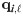
Method adopted to locate points qi,l on surface Q that correspond to points p¯i,l−1 on surface P in the lth iteration.Hashed points p¯i,l−1 (although moving through iterations) and black points q
j are original discrete points of the measurements of surface P and surface Q. Surface Q has been fitted to set of Zernike polynomials and expressed by Q(x,y) and thus represented in figure as a solid curve. Point qi,l in grey corresponds to, and has the same x and y coordinates as, p¯i,l−1 and hence is not necessarily one of the original discrete points q
j.